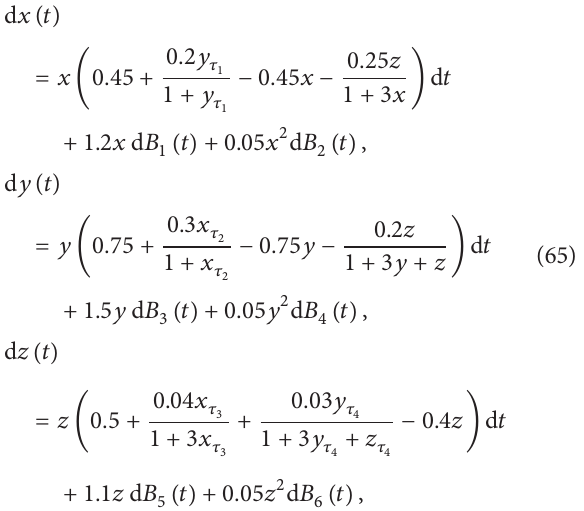
Figure 2: (Extinction) the trajectories of the solution (𝑥(𝑡),𝑦(𝑡),𝑧(𝑡)) for subsystem (65) and its corresponding deterministic system.